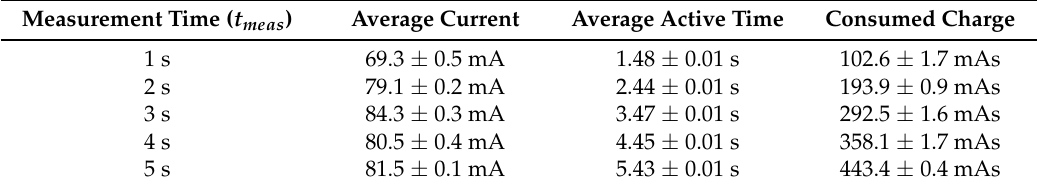
Table 4. Consumption in “measuring-only” state. Data for different values of t meas are shown.